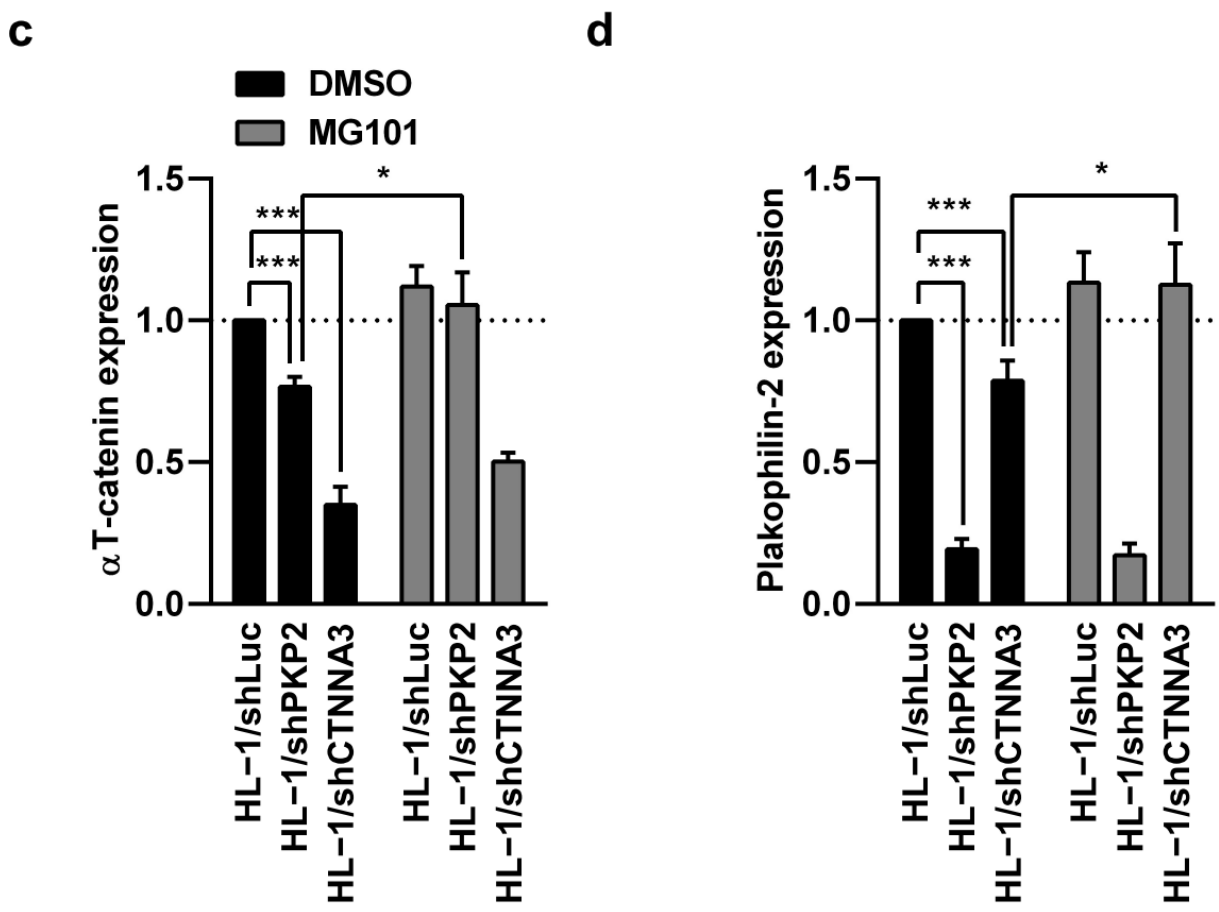
Figure 4. Knockdown of CTNNA3 and PKP2 affected each other’s protein levels, but not each other’s mRNA expression. ( a ) The mRNA levels of HL-1/shLuc, shCTNNA3, and shPKP2 stable cell lines were measured by real-time PCR using Power SYBR Green PCR Master Mix. Relative expres- sion of CTNNA3 and PKP2 mRNA was normalized by β -actin. This graph was from three inde- pendent experiments. ( b ) Protein levels in HL-1/shLuc, shCTNNA3, and shPKP2 cardiomyocytes